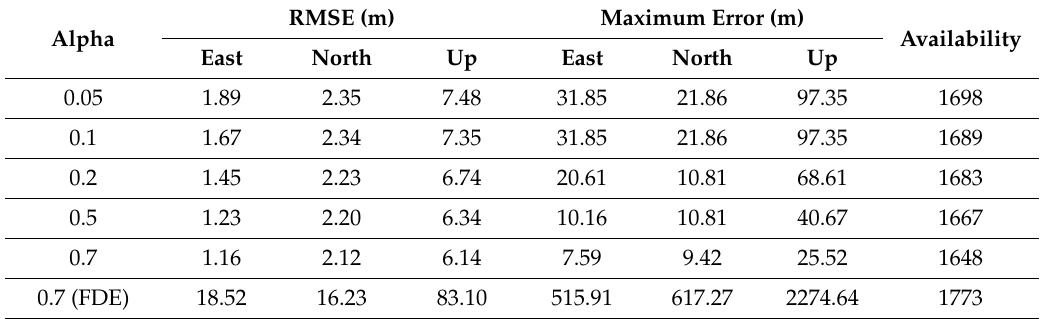
Table 12. Comparison of positioning accuracy and availability of D1 using Chi-square test based on di ff erent false alarm